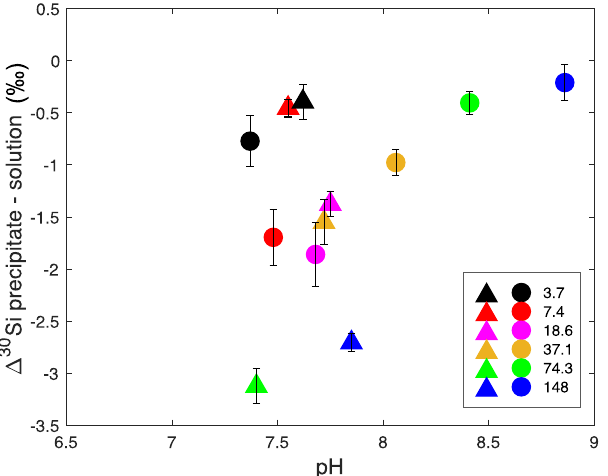
Figure 3. Si isotopic fractionation ( (cid:31) 30 Si p-s ) as a function of pH during the initial kinetic (triangles) reaction and at equilibrium (circles) for the range of dissolved Si concentrations 3.7–148 mM. Data are also presented in Supplementary Table